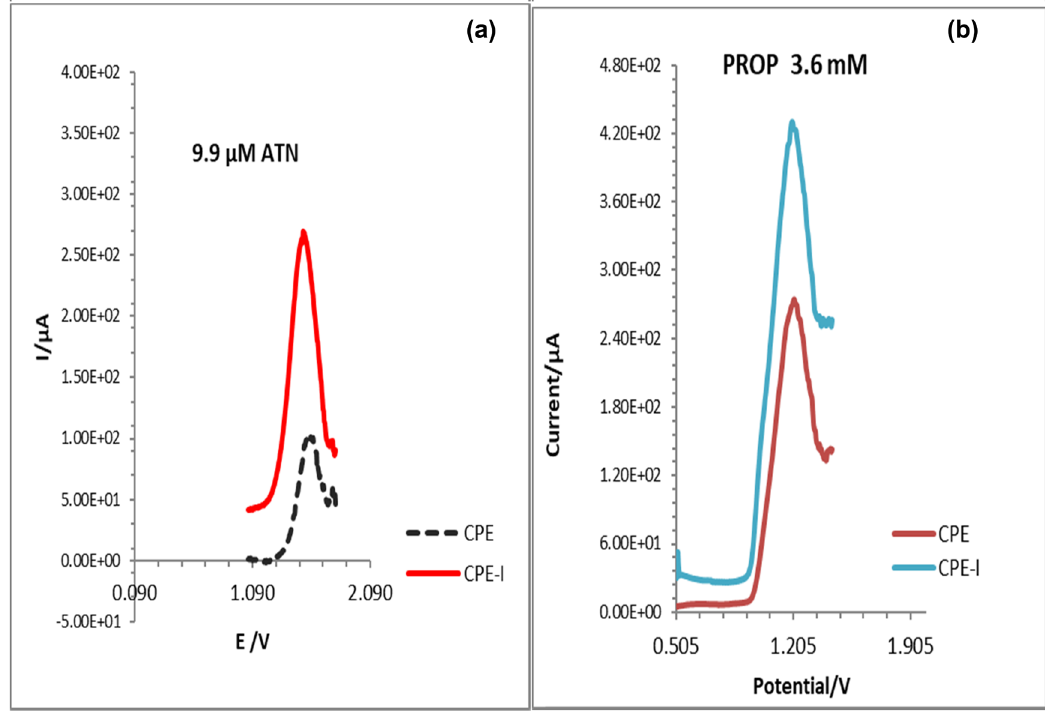
Figure 2: Square wave voltammograms of ( a ) 9.9 µmol L − 1 of ATN and ( b ) 3.6 mmol L − 1 of PROP at bare CPE and CPE - I in 0.1 mol L − 1 of H 2 SO 4 solution ( pH 2 ) with pulse amplitude of 30 mV and frequency of 25